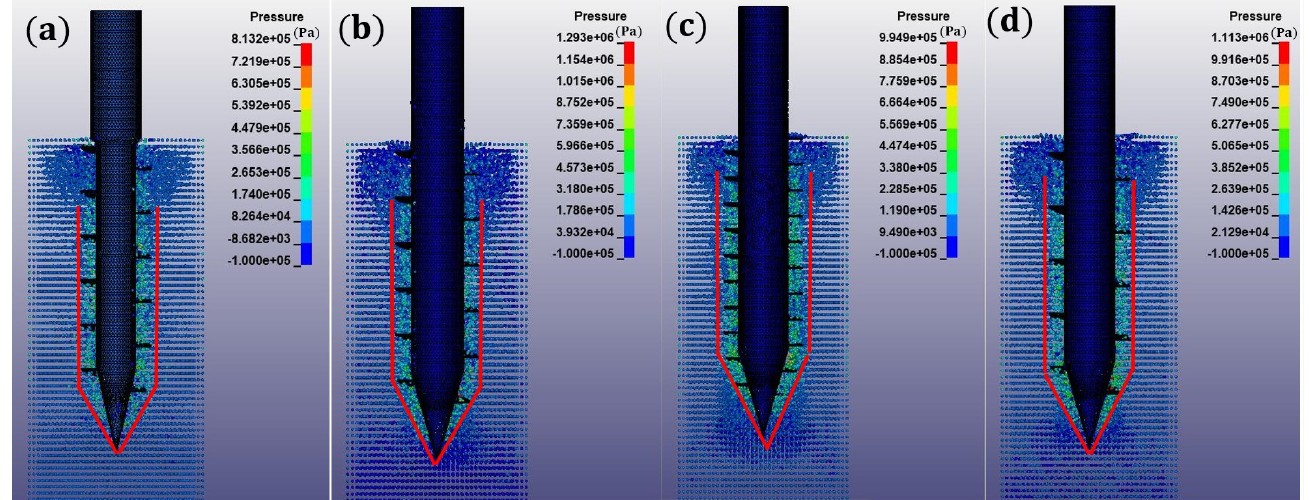
Figure 18. Soil pressure contour caused by the installation of the screw pile: ( a ) NT2, ( b ) NT3, ( c ) NT4 and ( d ) NT5.